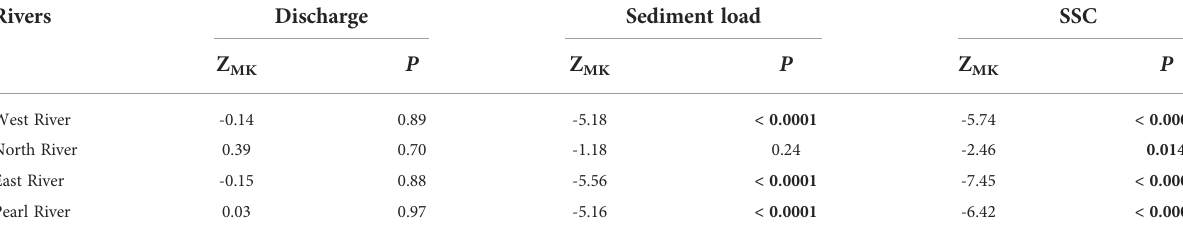
TABLE 3 Results of M-K test for annual discharge, sediment load and SSC.